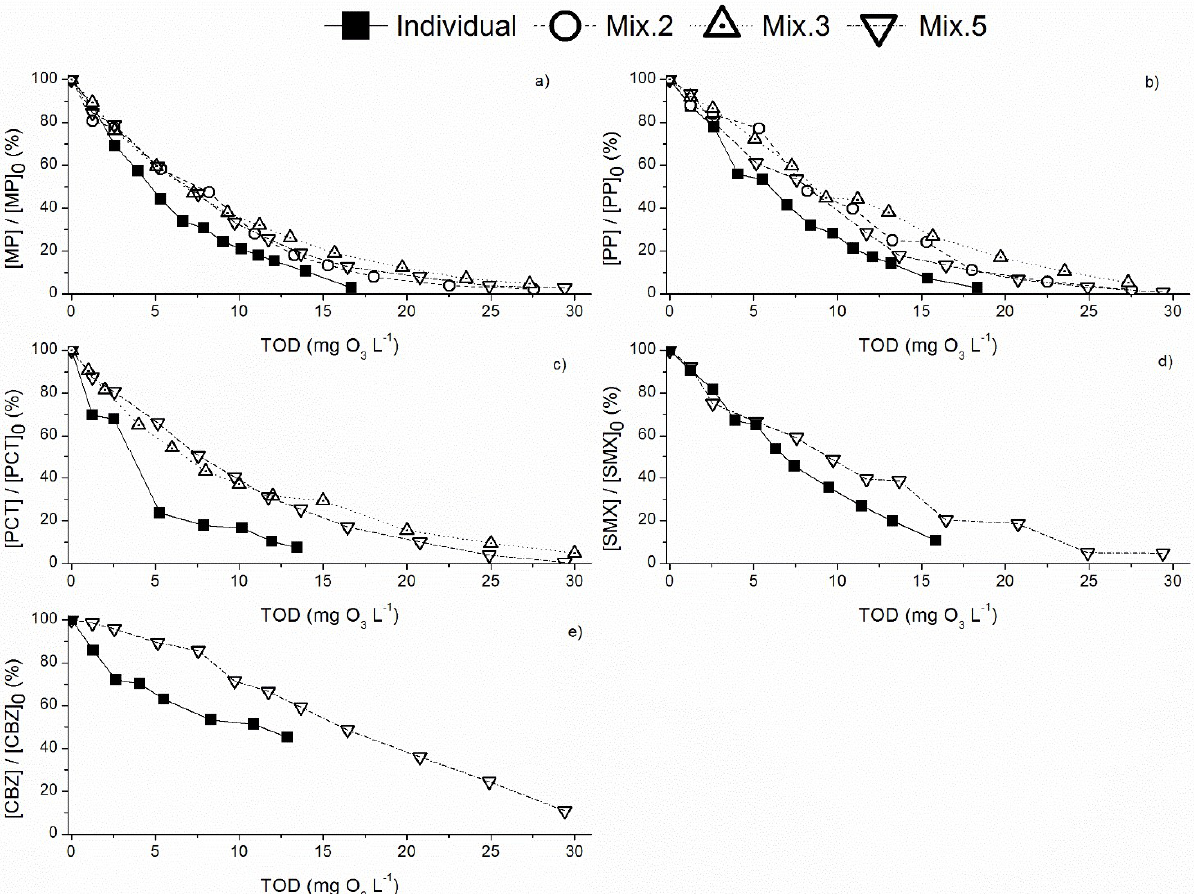
Figure 2. Normalized concentration of: ( a ) MP; ( b ) PP; ( c ) PCT; ( d ) SMX; ( e ) CBZ, during ozonation of individual PPCPs and the corresponding mixtures (Mix2, Mix3 and Mix5), throughout the TOD values, using a municipal wastewater as matrix at pH 7 and initial concentration of each PPCP 1 mg L −1 . Mix2 included MP and PP; Mix3 included MP, PP and PCT; and Mix5 included MP, PP, PCT, SMX and CBZ.